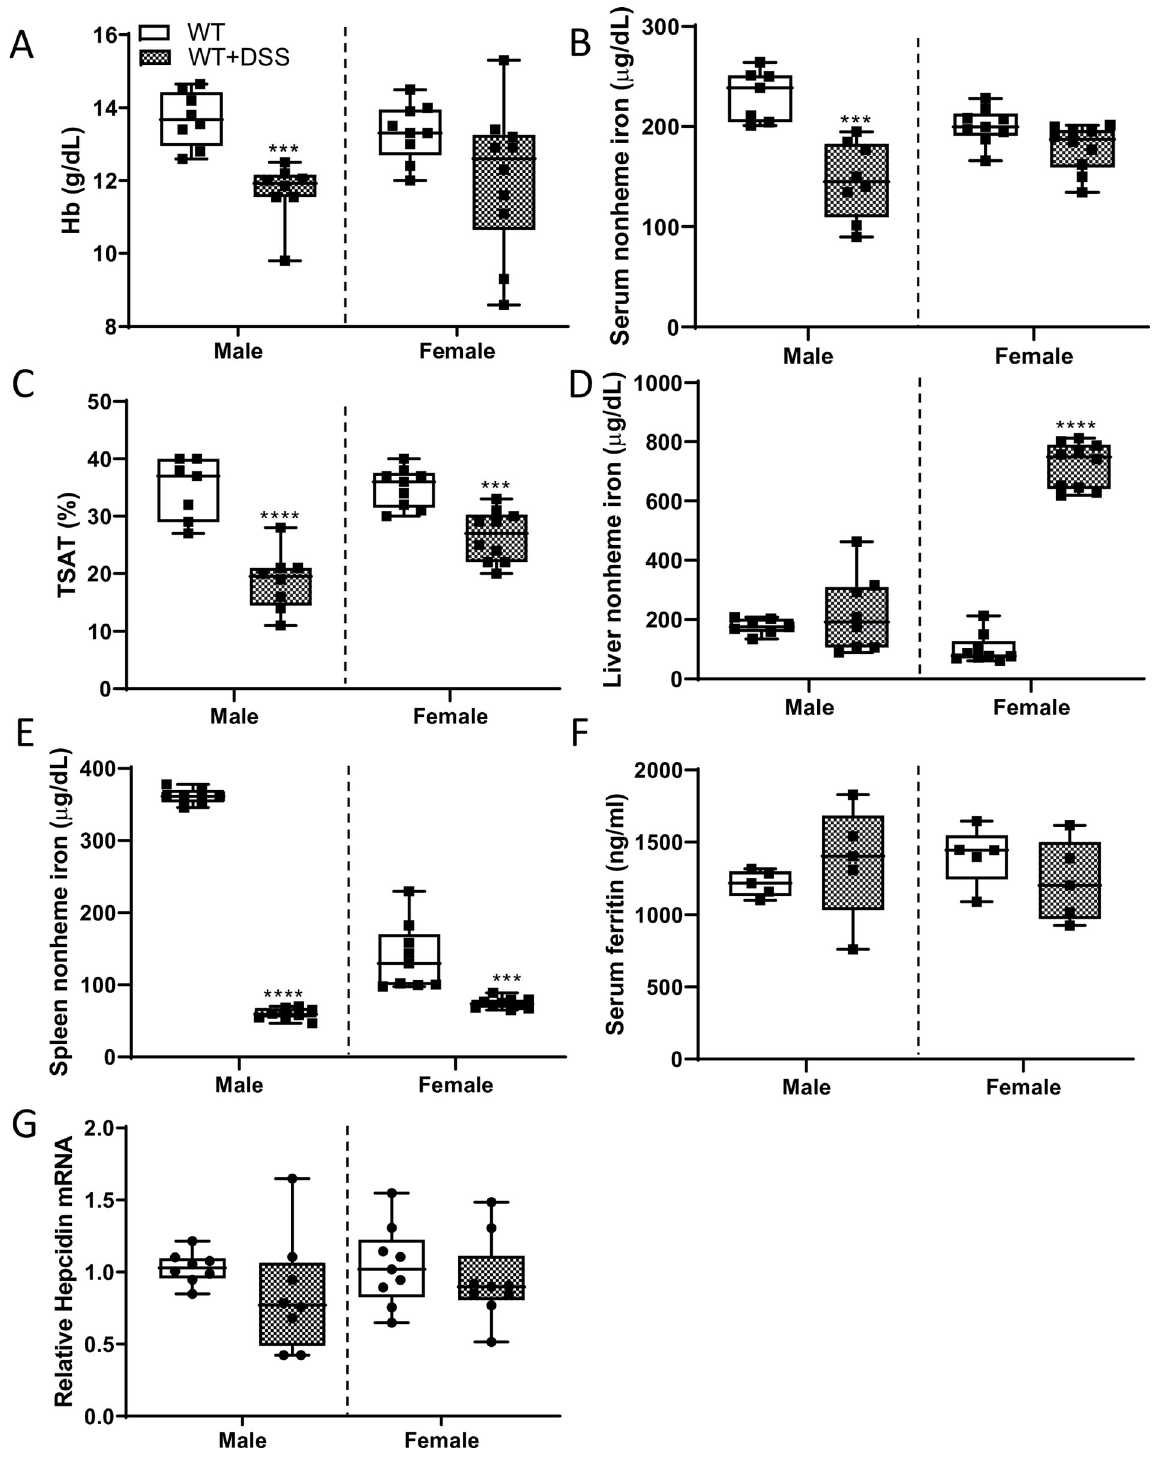
Fig 15. Acute colitis causes a reduction in serum nonheme iron and TSAT, and depletion of splenic iron stores in WT rats. Various iron- related physiological parameters were assessed in 10-week-old control and DSS-treated WT rats of both sexes. Hb levels are presented in panel A . Also shown are serum nonheme iron levels ( B ), TSAT ( C ), and liver (D ) and spleen ( E ) nonheme iron levels. ELISA results for serum ferritin ( F ) and liver hepcidin mRNA expression by qRT-PCR ( G ) are also shown. Data are presented as box plots representing two independent experiments with n = 5–11 rats/group with sexes analyzed separately using a t-test ( ��� p < 0.001; ���� p < 0.0001.